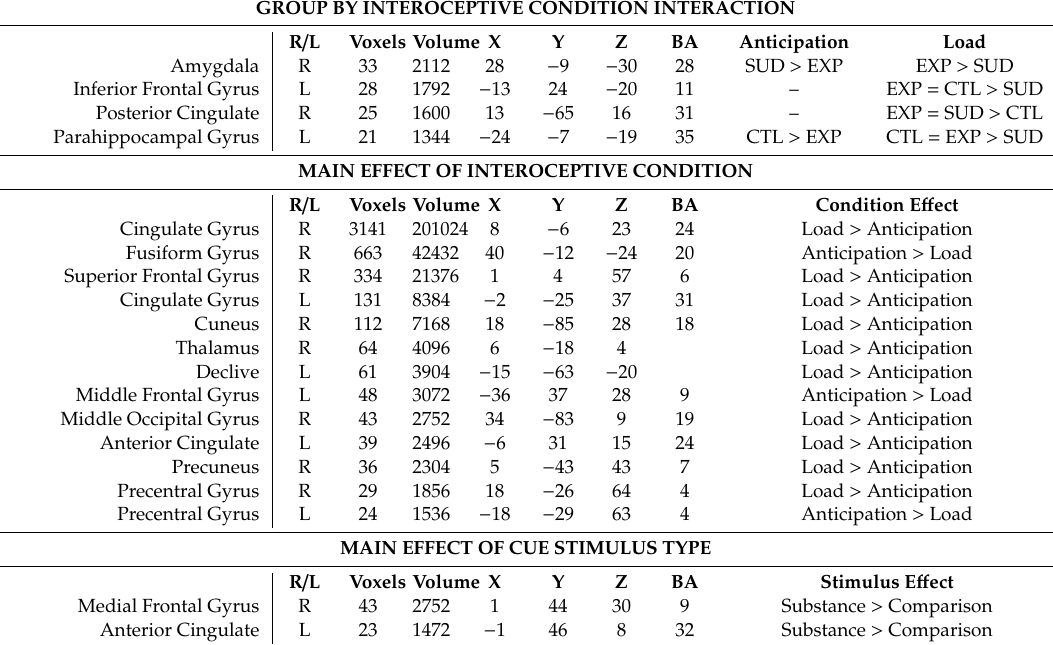
Table 3. fMRI results and between-group comparisons (SUD = CAN + ALC-SUD; EXP = CAN +